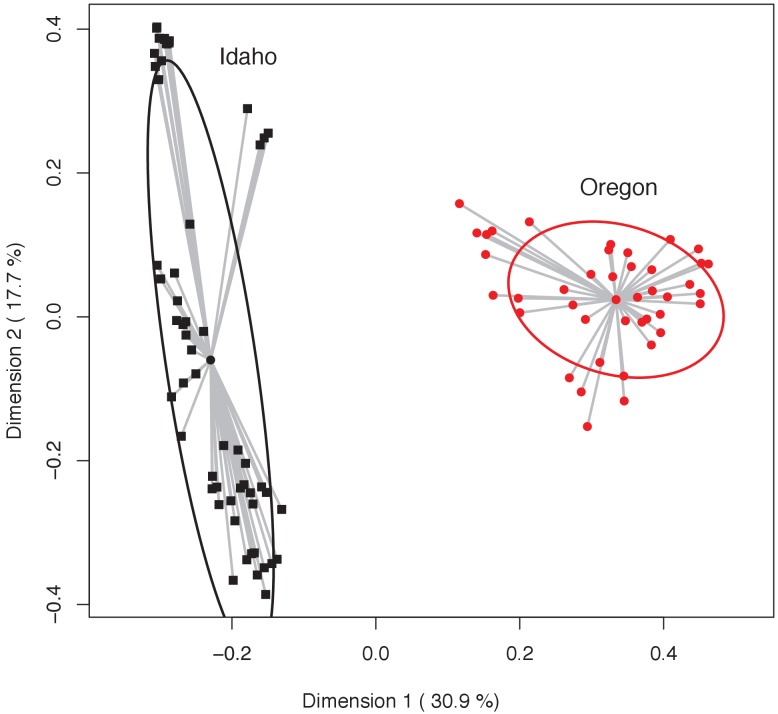
Principal coordinates analysis highlighting variation in bacterial community structure (Bray-Curtis index) of Oregon (red circles) and Idaho (black squares) newt skin microbiota.Dispersion (i.e. variance) of individual samples are shown as gray lines from the mean centroid, and 95% confidence ellipses are shown for each group. Permutation test of multivariate homogeneity of group dispersion (PERMDISP) indicates a significant difference between the two populations (p=0.0053).